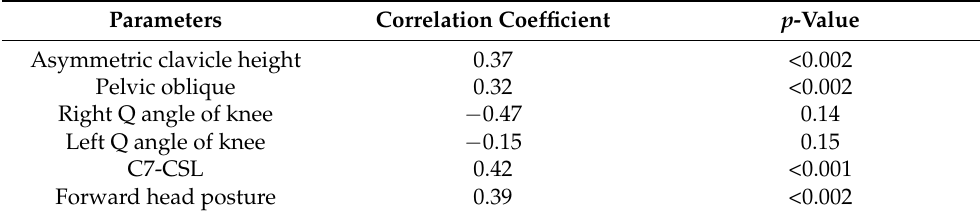
Table 4. The Pearson correlation coefficient (r) for validity between PAViR and EOS. Parameters Correlation Coefficient p